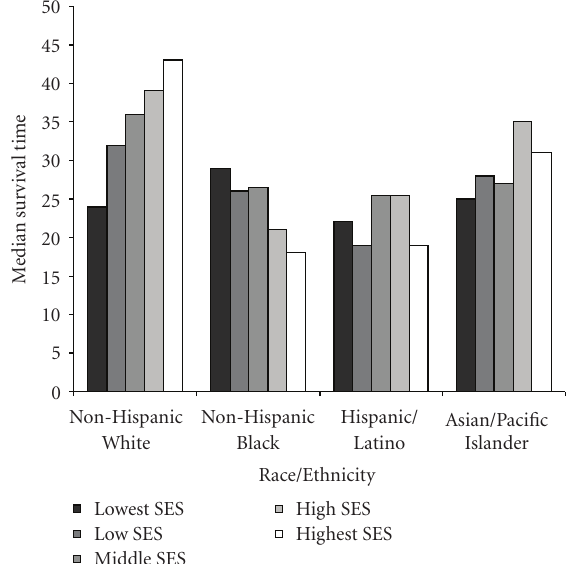
Figure 1: Racial/ethnic breakdown of frequency of neighborhood- level socioeconomic status